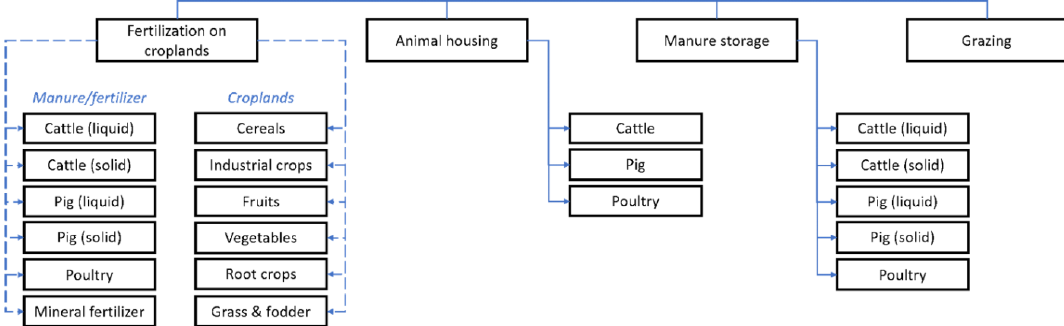
Figure C1. Categorization in the MACC-INTEGRATOR combined emission inventory. There are six fertilizer types and six crop types, resulting in 36 categories regarding fertilization. Together with three animal housing types, five manure storage types, and grazing, there are 45 categories in the new NH 3 emission